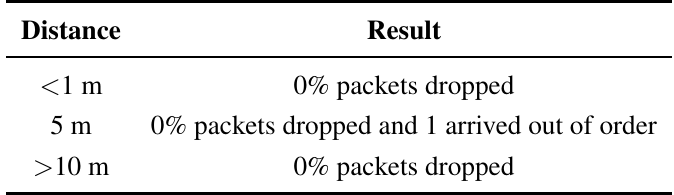
Table 2. Table summarizing the results from the reliability test with a Raspberry